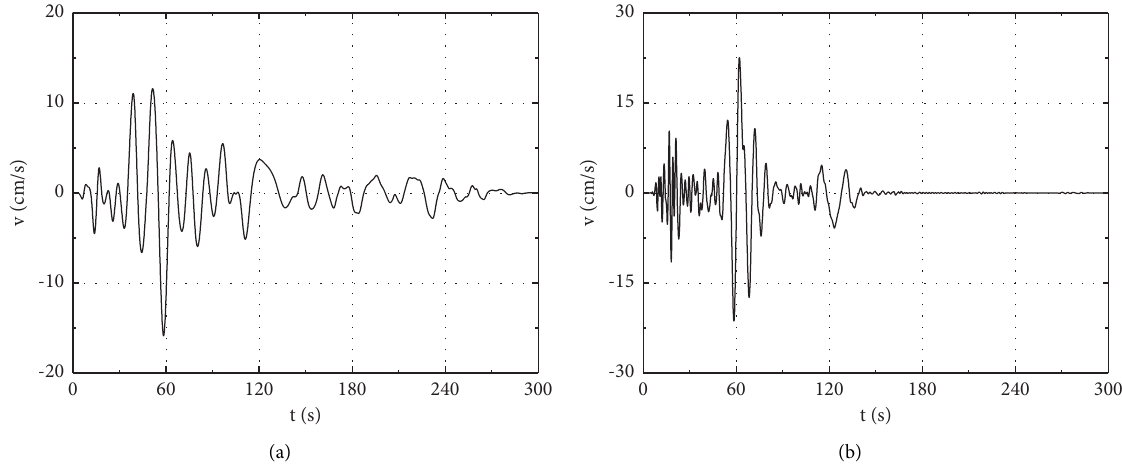
Figure 14: 2 Hz frequency threshold. (a) The low-frequency signal. (b) The high-frequency signal.